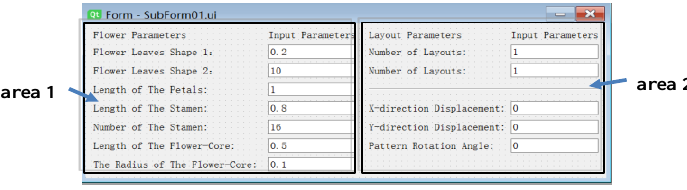
Figure 13. Parameter setting module.